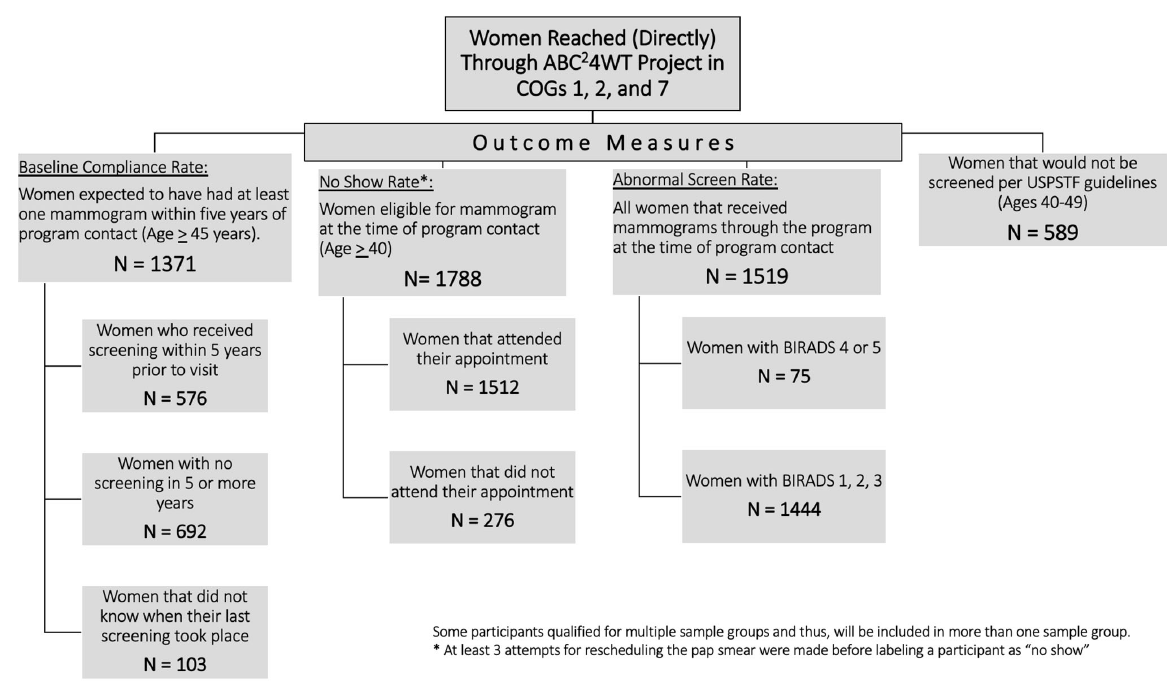
Figure 2. Flow diagram showing the distribution of ABC4WT participants and outcome